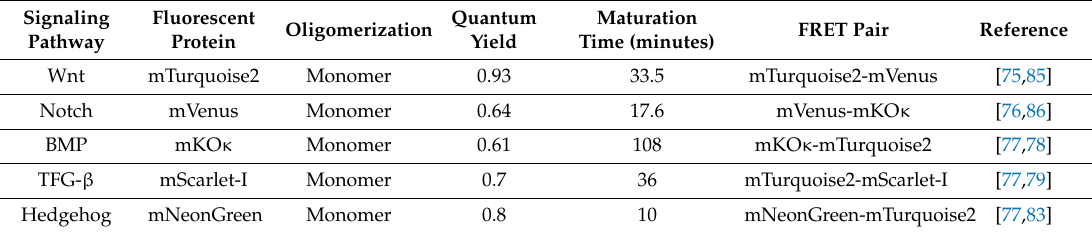
Table 2. Multi-reporter